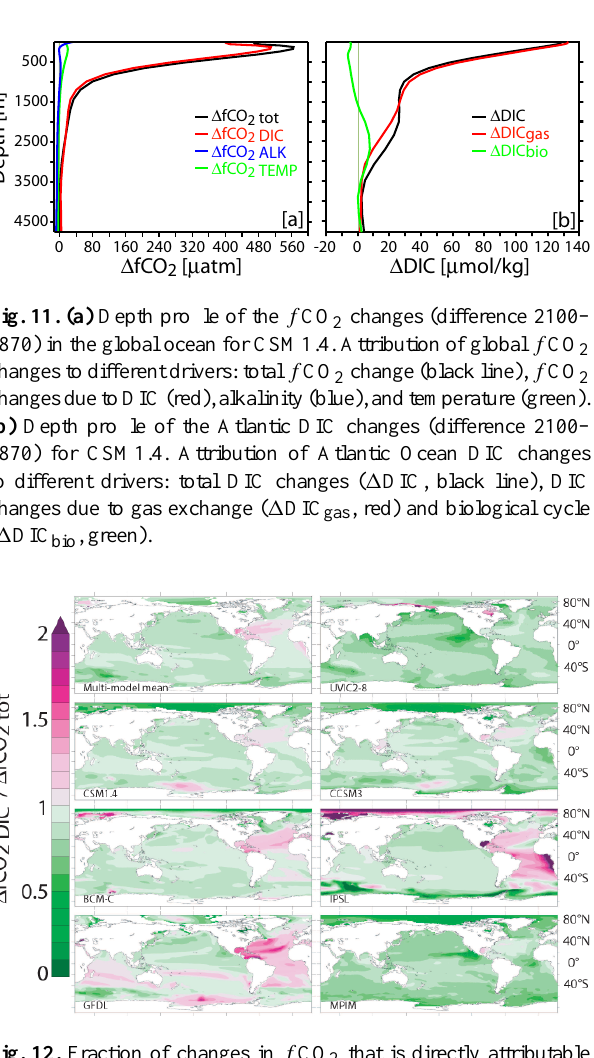
Fig. 12. Fraction of changes in f CO 2 that is directly attributable to changes in DIC. Changes are for the UML (100 to 600m depth) and for 2090s relative to 1870s (decadal average). The multi-model mean is given in the upper left panel.